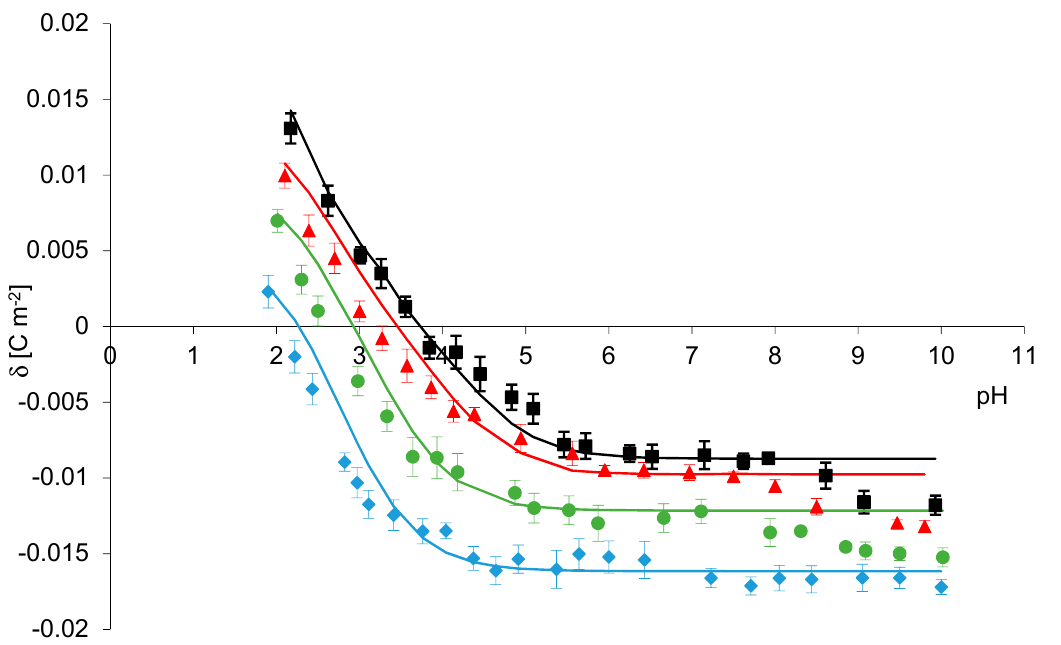
Figure 2. Surface charge density of phosphatidylcholine membrane versus pH of electrolyte solution. Points denote the experimental values, continuous line links the theoretical values NaCl (black), NaBr (red), NaNO 3 (green), NaI (blue). Table 2. Association constants of phosphatidylcholine functional groups with monovalent ions (H + , Na + , OH − , Cl − , Br − , NO 3 − , I −